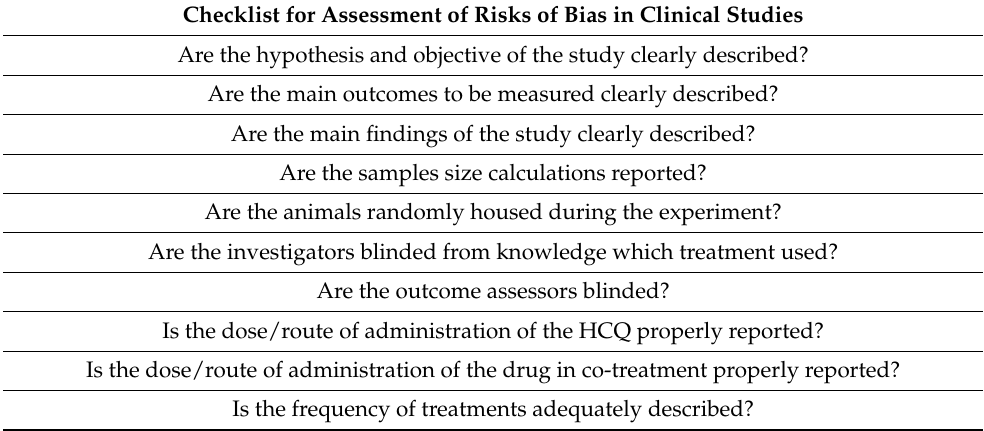
Table 5. Checklist for assessment of risks of bias in clinical studies